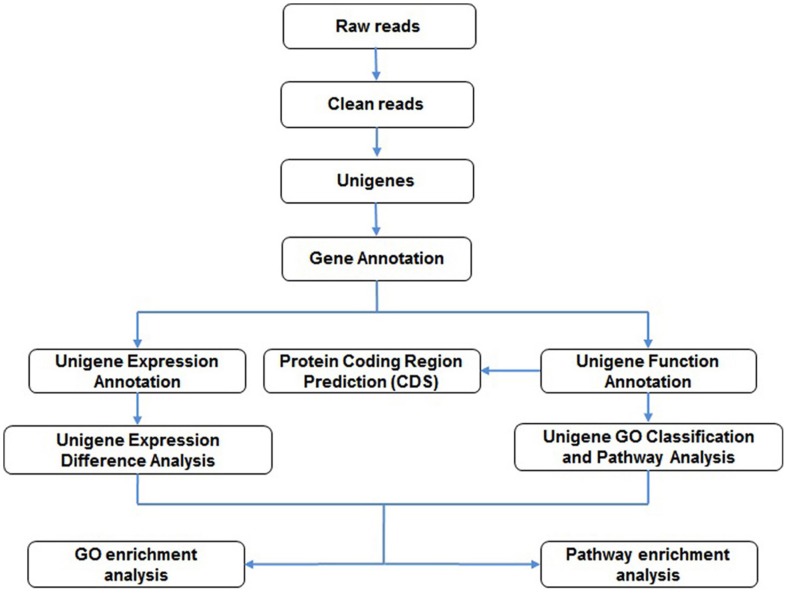
Pipeline of bioinformatics analysis.